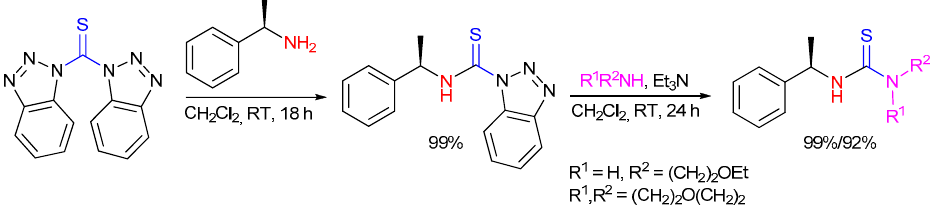
Figure 2. Bis-imidazole thiourea used in the synthesis of other derivatives [92]. 2.6. C=S Bond Formation Less frequently, thioureas have been prepared via multi-component reactions in which elementary sulfur or other sulfur-transfer agents are used to form the C=S bond. Hydrogen sulfide was used by Katritzky et al. as the source of sulfur and reacted with 1-cyanobenzotriazole and amines or with carboximidamides to give thioureas in reasonable to high yields (54–99%, with two